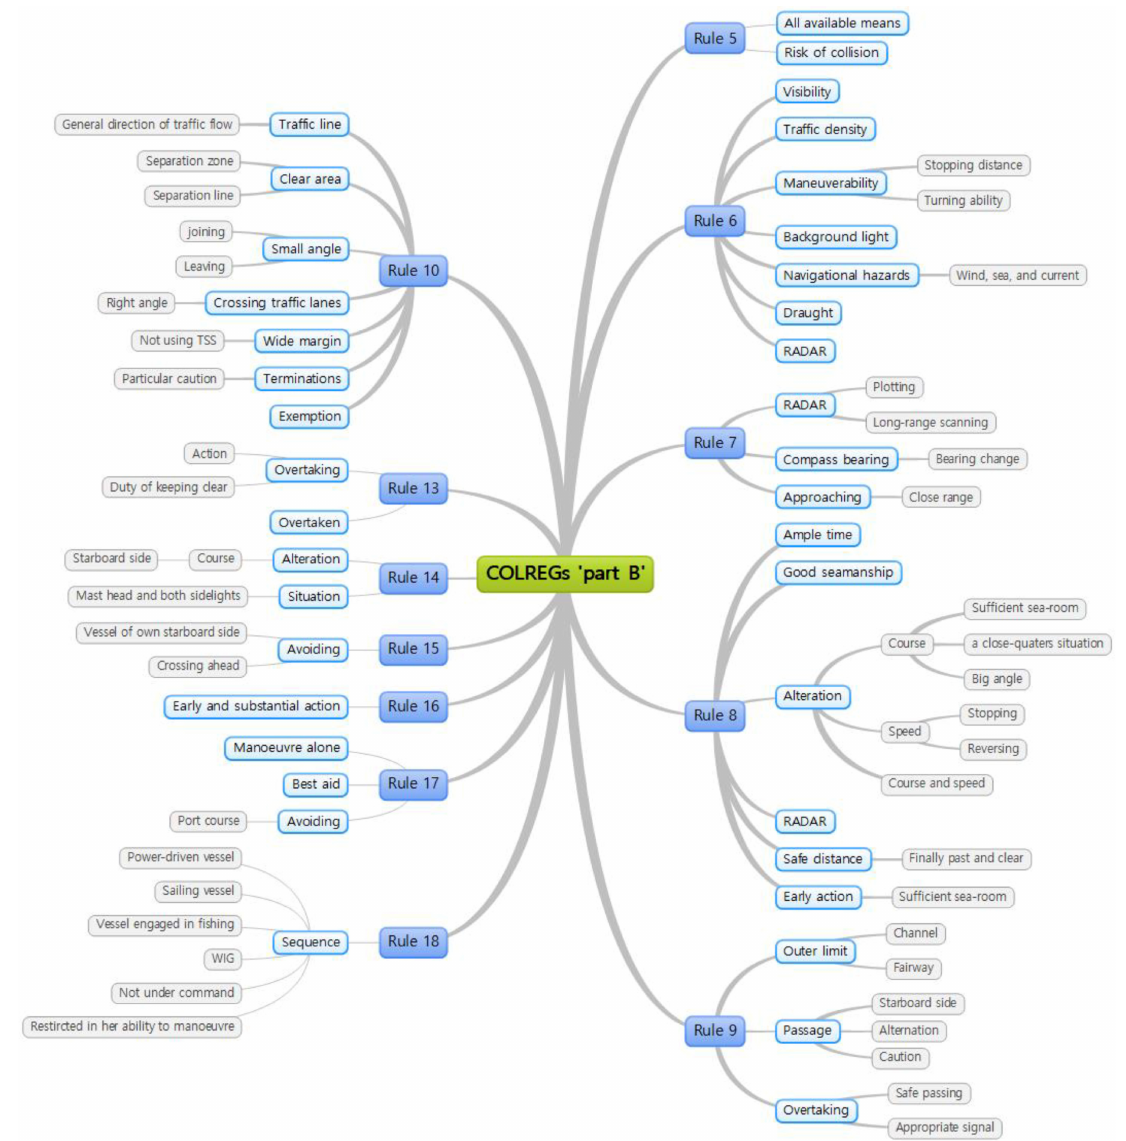
Figure 4. Extraction of keywords from COLREGs part